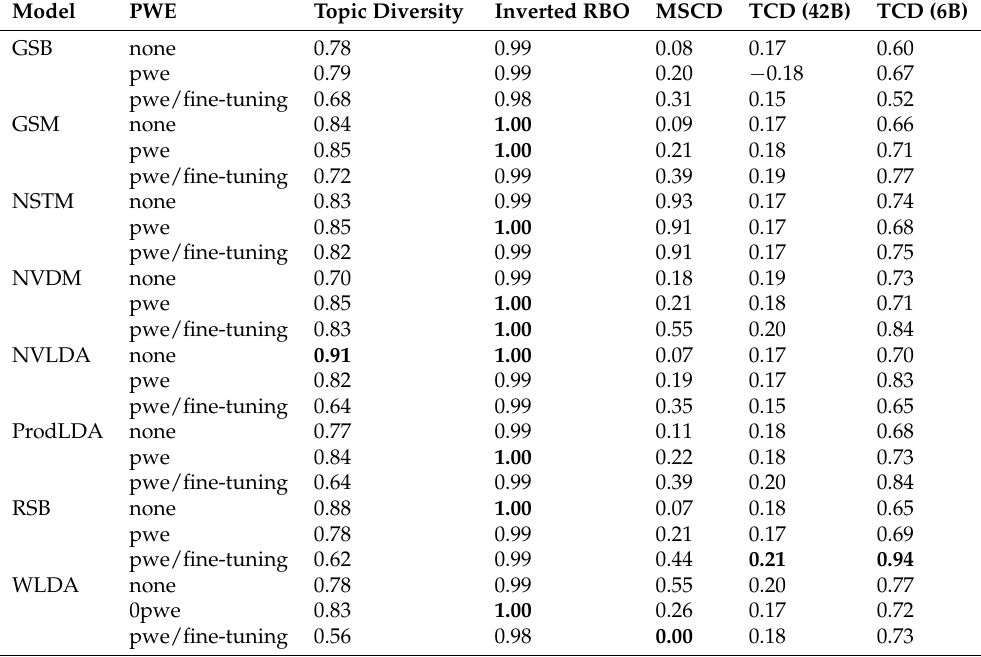
Figure 5. Summary of TD Results. Table 13. Topic Diversity on